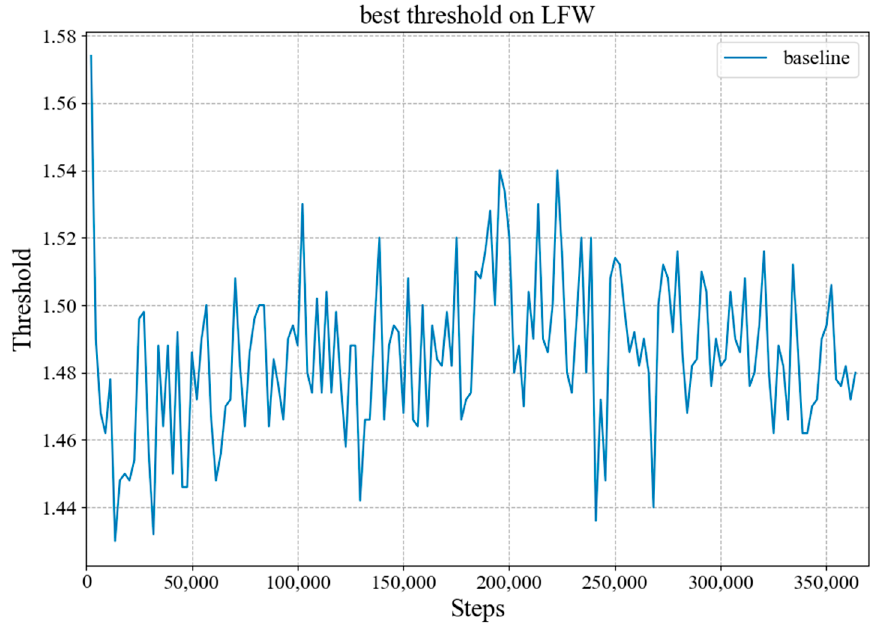
Figure 7. The best threshold of the baseline on LFW during the training stage. Table 3. The test results of the baseline. The data in the columns of LFW, AgeDB-30, VGG2-FP, CALFW, CPLFW, CFP-FF, and CFP-FP represent the accuracy of the model on different test sets. These test sets are described in detail in Section 4.1.